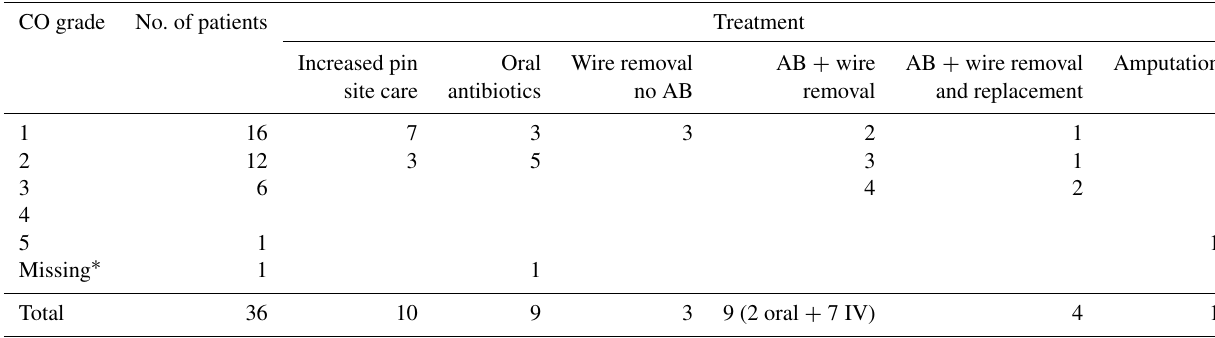
Table 3. Treatment of pin sites infection according to the highest registered CO